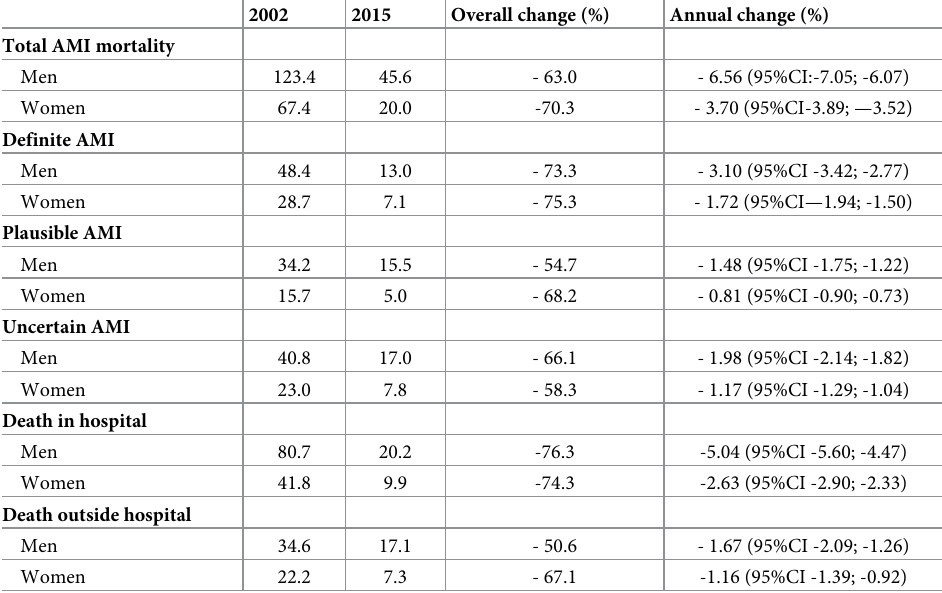
Table 2. Trends in mortality rates from acute myocardial infarction by gender, diagnostic support, and place of death.